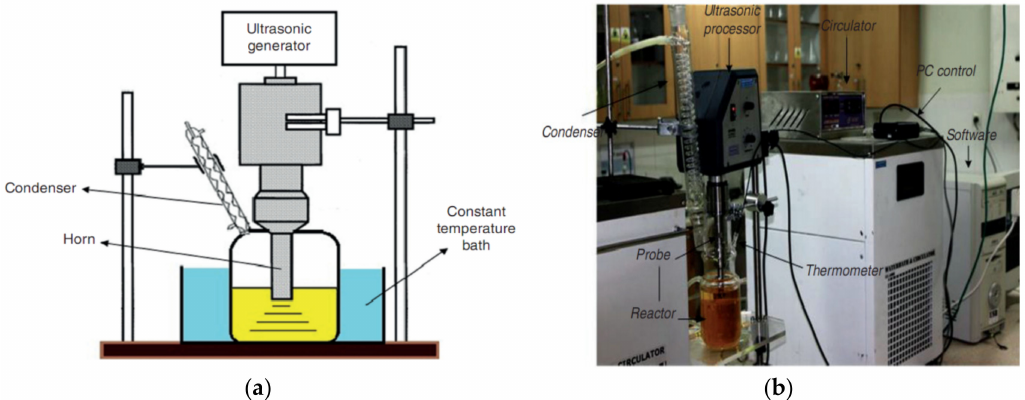
Figure 2. The biodiesel production set-up: ( a ) schematic; ( b ) device